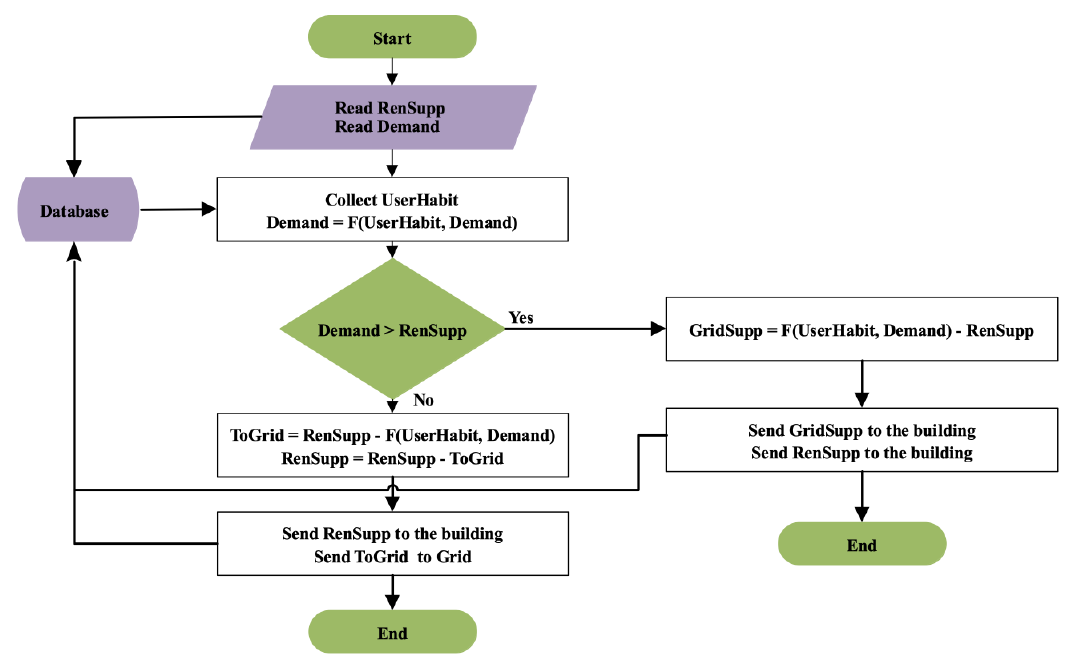
Figure 6. The electricity management